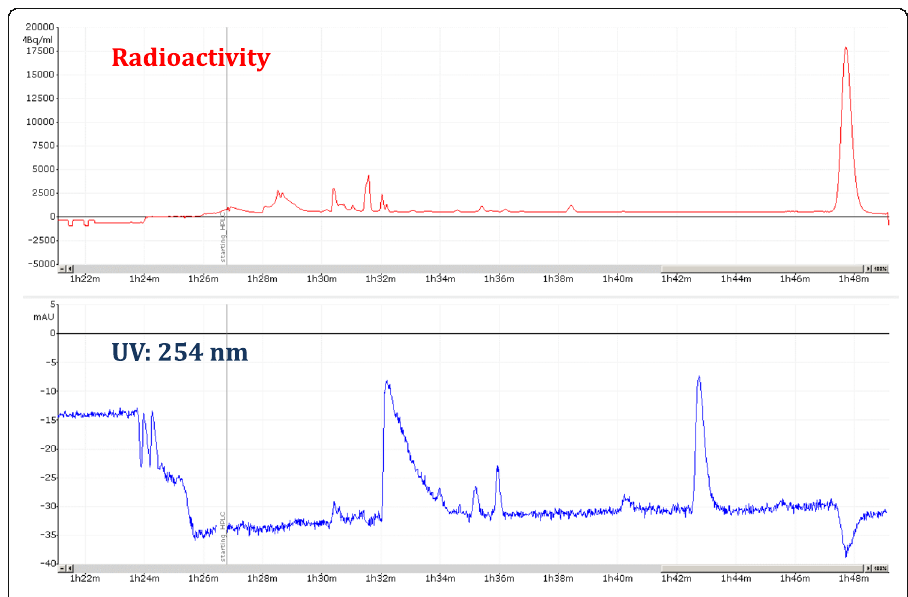
Fig. 11 A view of typical semi-preparative chromatogram of [ 18